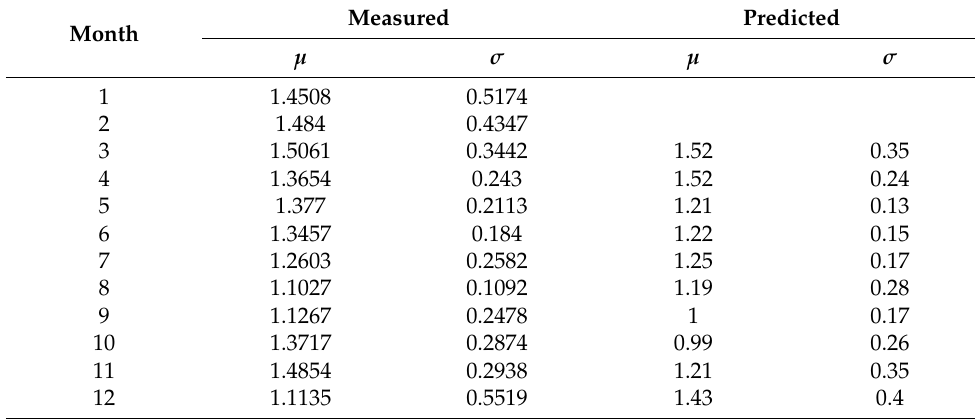
Table 3. Measured and predicted values of the Lognormal PDF parameters.